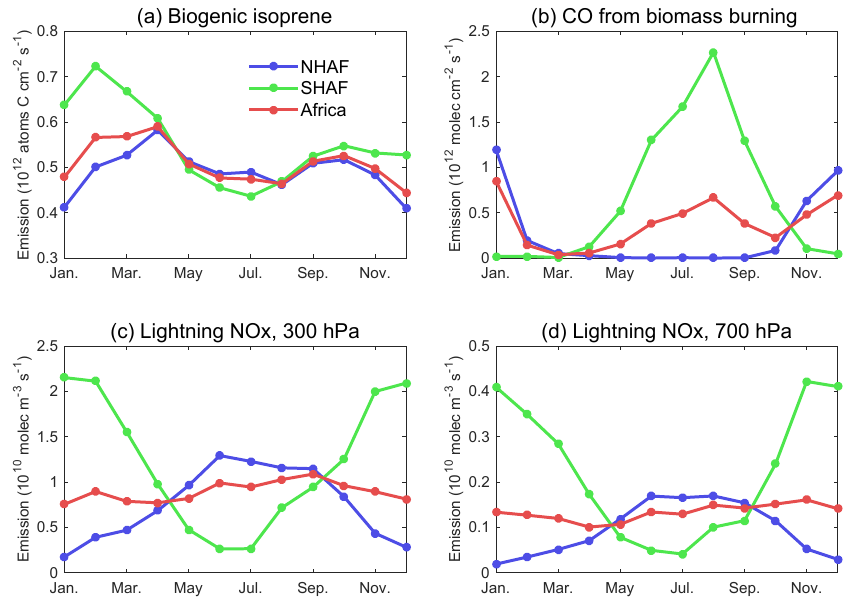
Figure 9. Seasonal variations for (a) isoprene emissions from biogenic sources, (b) CO emissions from biomass burning, NO x emissions from lightning at (c) 300hPa, and (d) 700hPa averaged over Africa, NHAF, and SHAF in 2005.